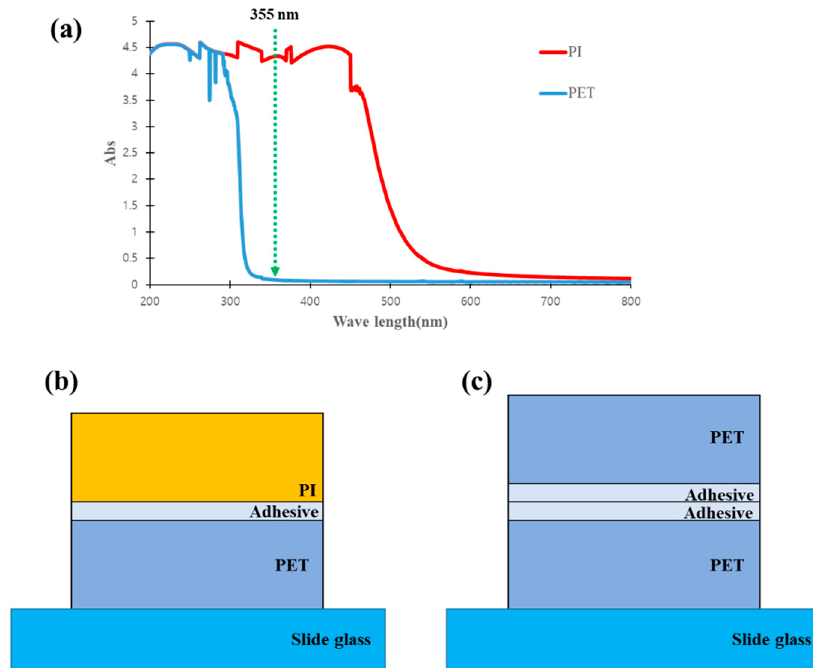
Figure 2. ( a ) Absorption spectrum results for two types of polymer materials using UV–Vis spectrophotometry and configuration of the samples prepared for the experiment: ( b ) polyimide (PI) and ( c ) polyethylene terephthalate (PET).